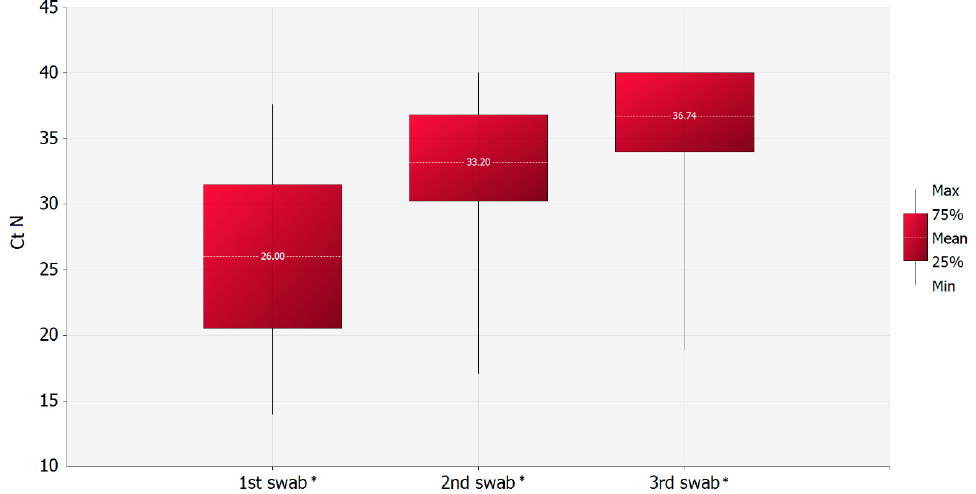
Figure 6. Time variation of the CT N gene mean values of patients with final double negative swab.*Asterisks are denoting the significant mean values of CT N gene ( p -value =